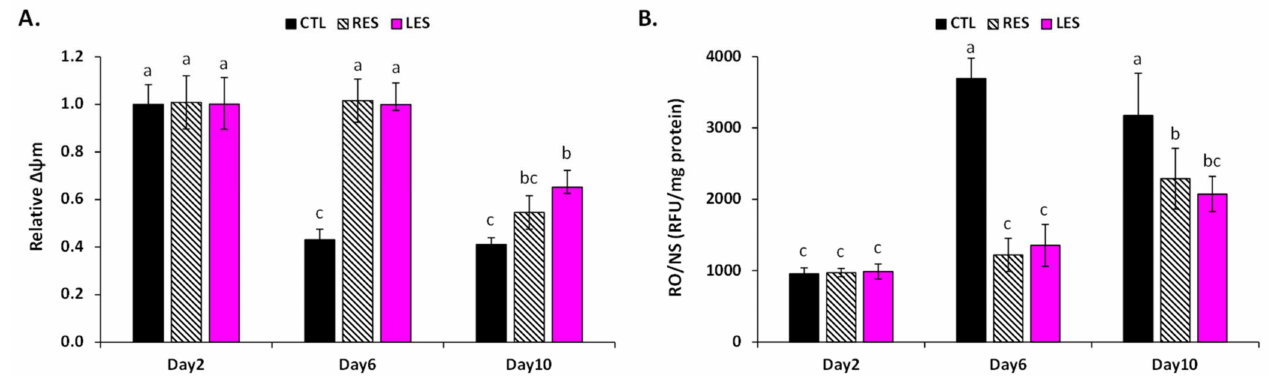
Figure 3. ( A ) Mitochondria integrity estimated by mitochondrial potential ( ∆Ψ m) variation; ( B ) pro- duction of reactive oxygen and nitrogen species (ROS/RNS) during aging evaluated at 3 different times (2, 6, and 10 days of culture). The evaluation of mitochondria membrane potential ( ∆Ψ m) was carried out by treating cells with 3,30-dihexyloxacarbocyanineiodide (DiOC6(3). ROS/RNS production was evaluated using the dihydrorhodamine-123 (DHR123) probe. LSE: sacred lotus stamen extract (0.5 mg/mL); RES: E-resveratrol (10 µ M) used as positive antiaging control. Significant differences ( p < 0.05) are shown by different letters.